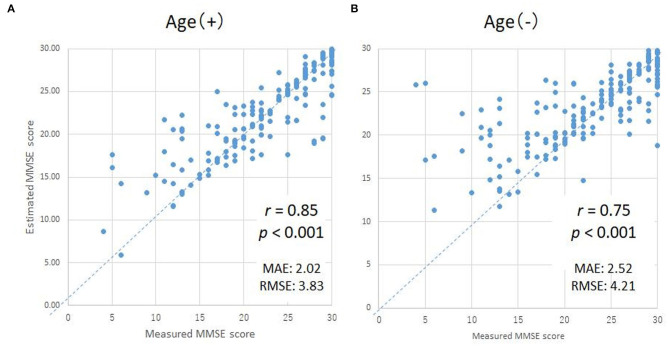
Scatter plots of the measured and predicted MMSE scores by DNN with age (A) and without age (B). The horizontal axes indicate the measured MMSE scores, while the vertical axes indicate the predicted MMSE scores by DNN.